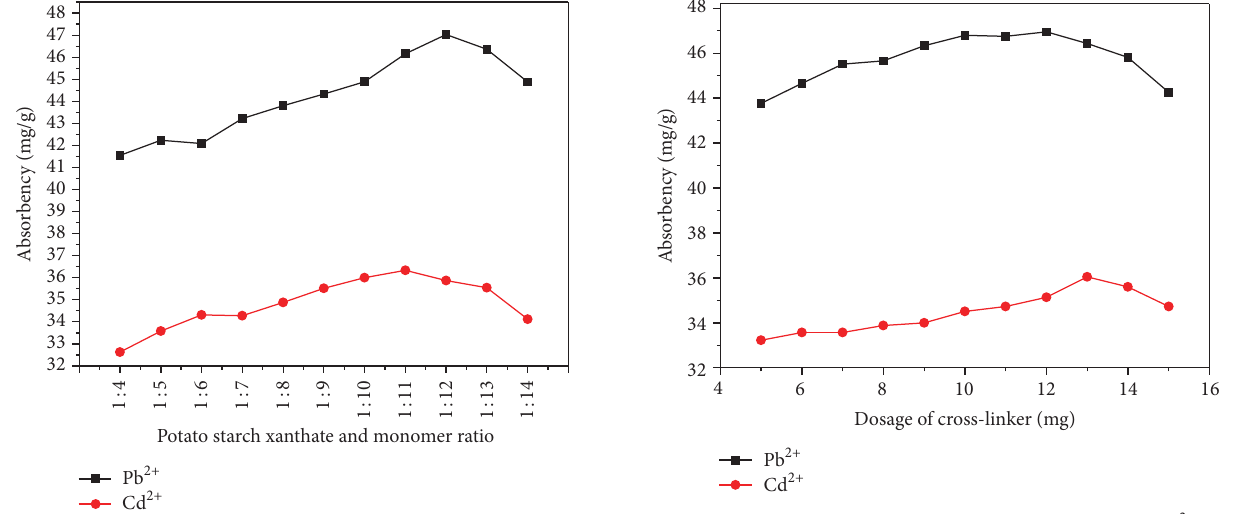
Figure 2: Effect of starch xanthate and monomer ratio on polymer adsorbed Pb 2+ and Cd 2+ .